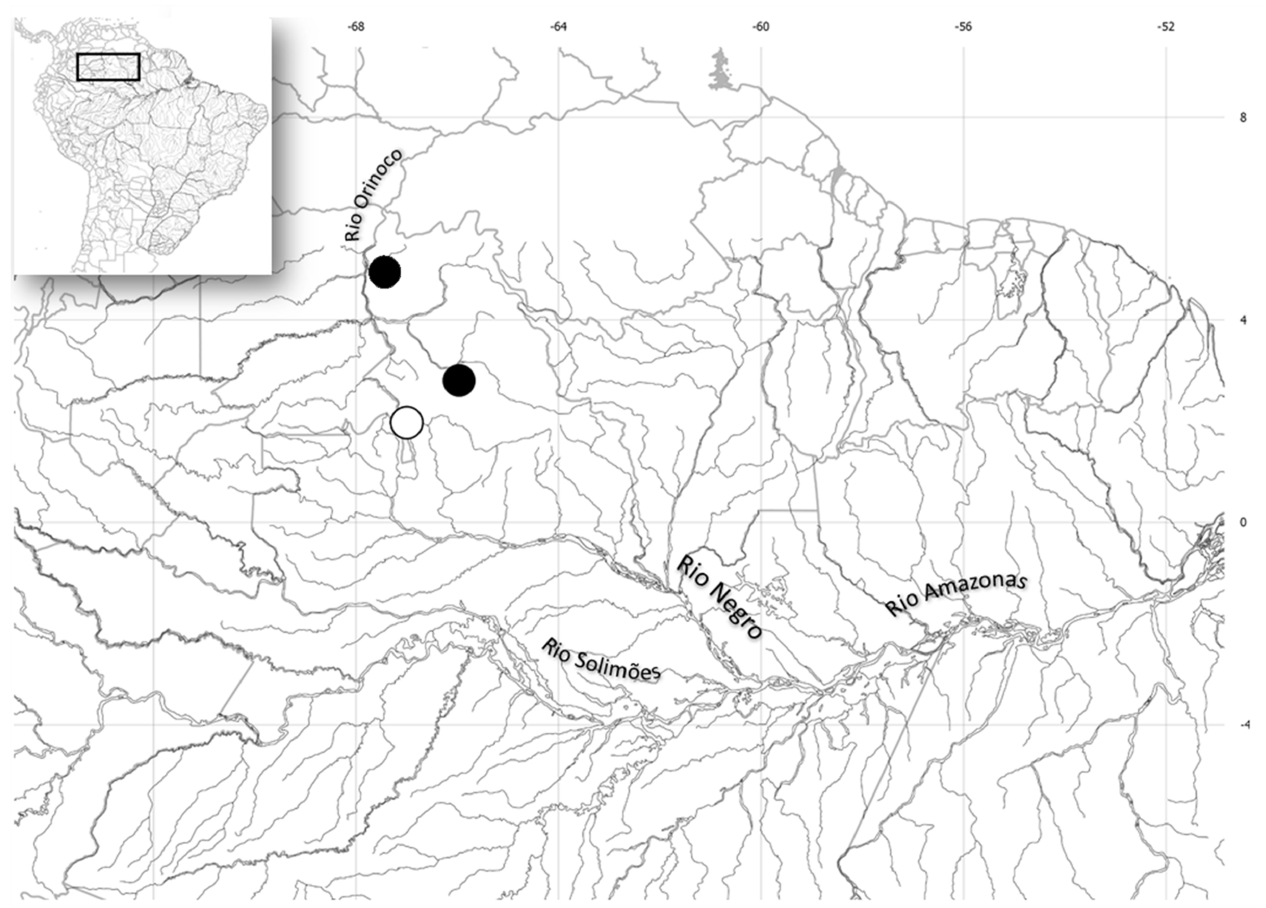
FIGURE 3 | Map of geographical distribution of Odontocharacidium varii (circles). Type-locality represented by the same symbol in white